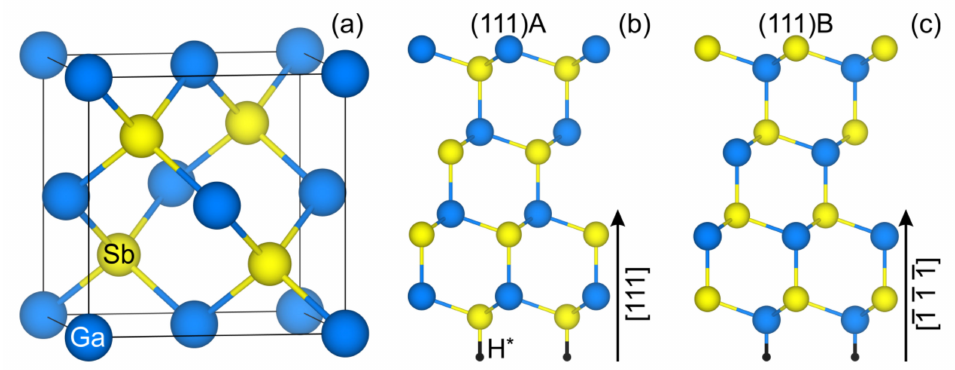
Figure 1. Atomic structure of bulk semiconductor GaSb ( a ) and the models of its surfaces under study: the (111)A ( b ) and (111)B ( c ). The side view of GaSb(111) surfaces is